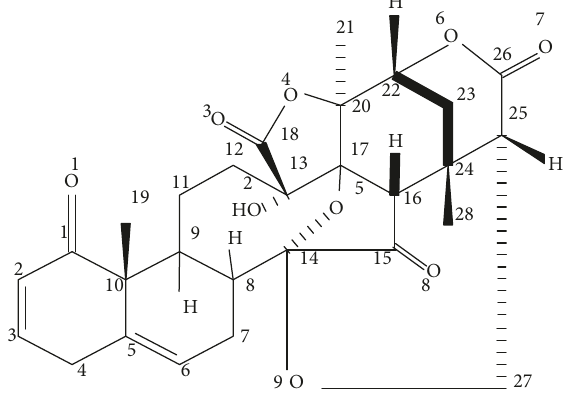
Figure 1: The structure of physalin